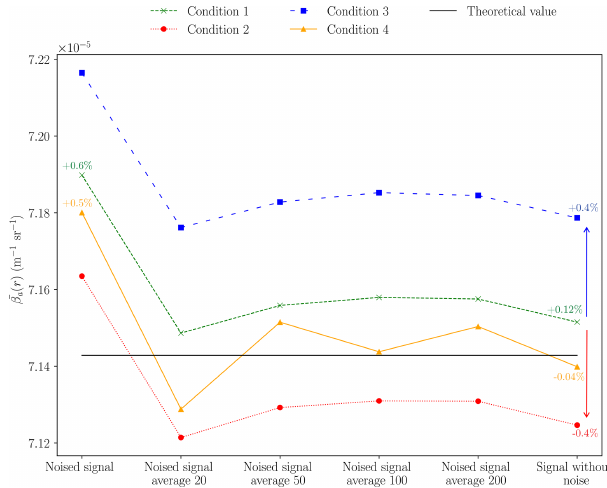
Figure 5. Retrieved β a for six datasets and four different conditions of inversion.